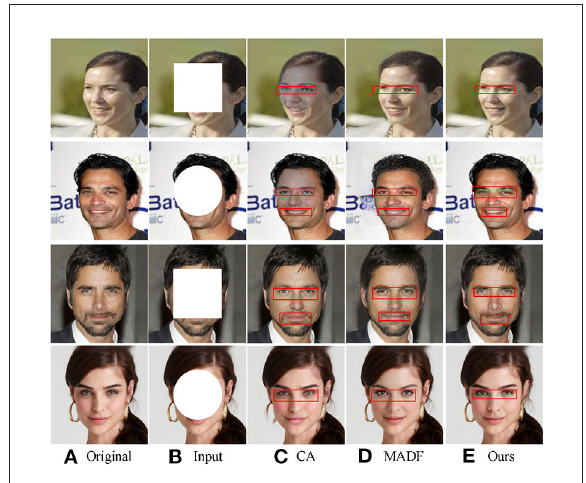
FIGURE5 Visual comparison of different image inpainting methods on CelebA-HQ and ParisView datasets with regular masks. Obvious differences on the faces are highlighted by red boxes. The face images are adapted from the celeba-HQ dataset, which comes from Karras et al. (2017).